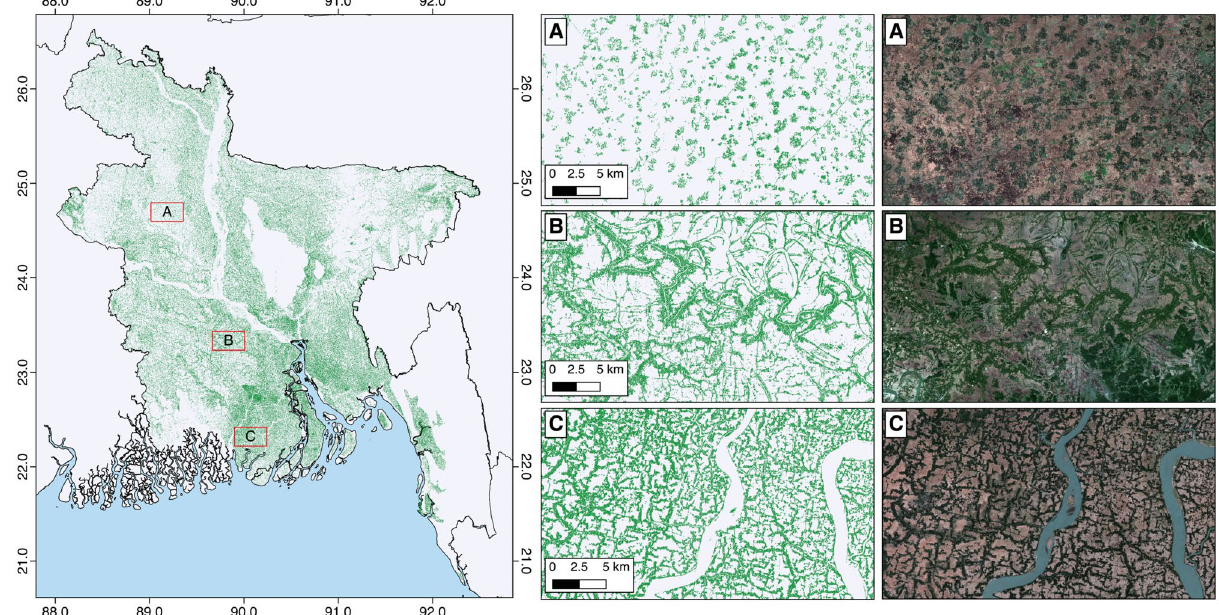
Figure 1. Distribution of trees outside forests (TOF) in Bangladesh. ( A ) Isolated stands of TOF in scattered dwellings ( B ) Less anthropogenically influenced TOF along rivers and geomorphological features ( C ) TOF in an agricultural region forming narrow stands around field boundaries. Map made with QGIS 2.8 (https:// www. qgis. org/ en/ site/ index. html).